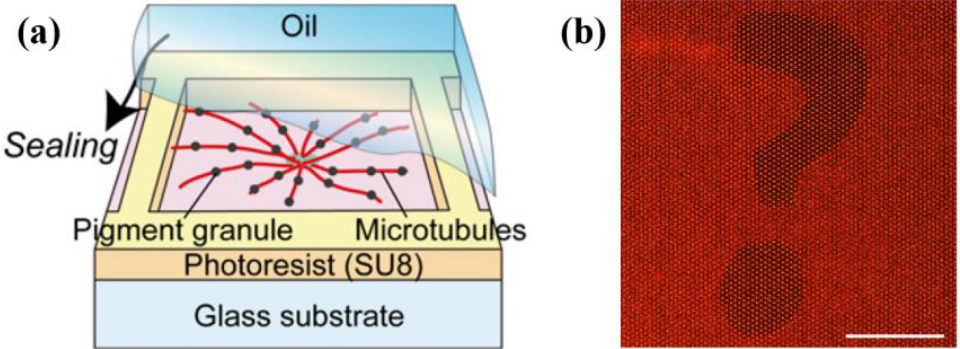
Figure 2. Self-organizing molecular transport system. ( a ) The schematic of the fish melanophore-like optical device. ( b ) A question mask pattern is clearly presented by this artificial optical device. Scale bar, 1 mm. Reprinted with permission from Reference [31], Copyright 2013, National Academy of Sciences.